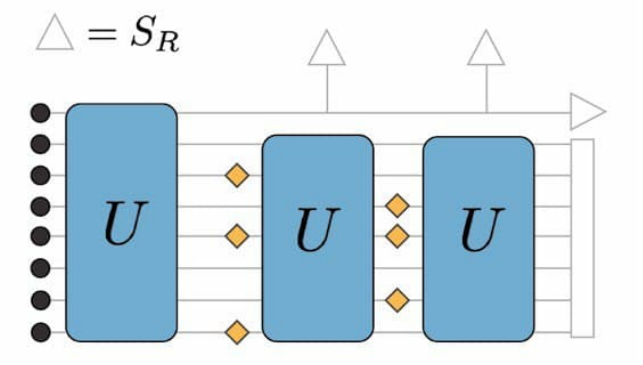
Figure 3: Scheme for the ancilla entanglement entropy. After a single time step fully entangling the ancilla qubit with the remaining of the system, the circuit is let evolve and the single qubit entropy S is computed on the ancilla at each time R